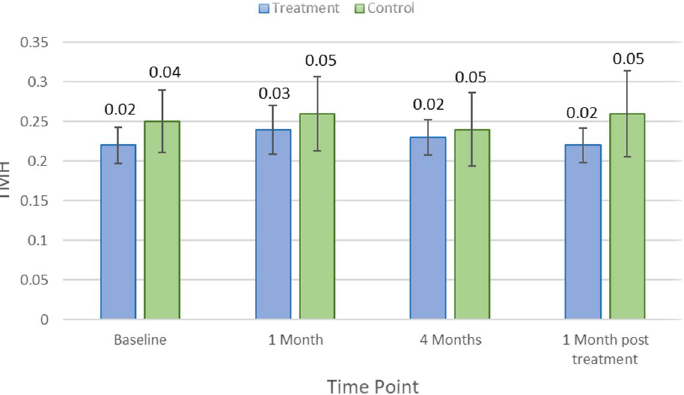
Figure 2. Mean non-invasive keratograph break-up time (NIKBUT) at each study time point in the treatment and control groups. Error bars are 95% confidence intervals.